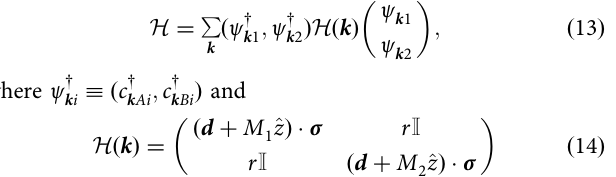
p ffiffiffiffiffiffiffiffiffiffiffiffiffiffiffiffiffiffiffiffi ffiffiffiffiffiffiffiffiffiffiffiffiffiffiffiffiffiffiffiffi j d j þ M z p ffiffiffiffiffiffiffiffiffiffiffiffiffiffiffiffiffiffiffiffi ffiffiffiffiffiffiffiffiffiffiffiffiffiffiffiffiffiffiffiffi j d j (cid:3) M z